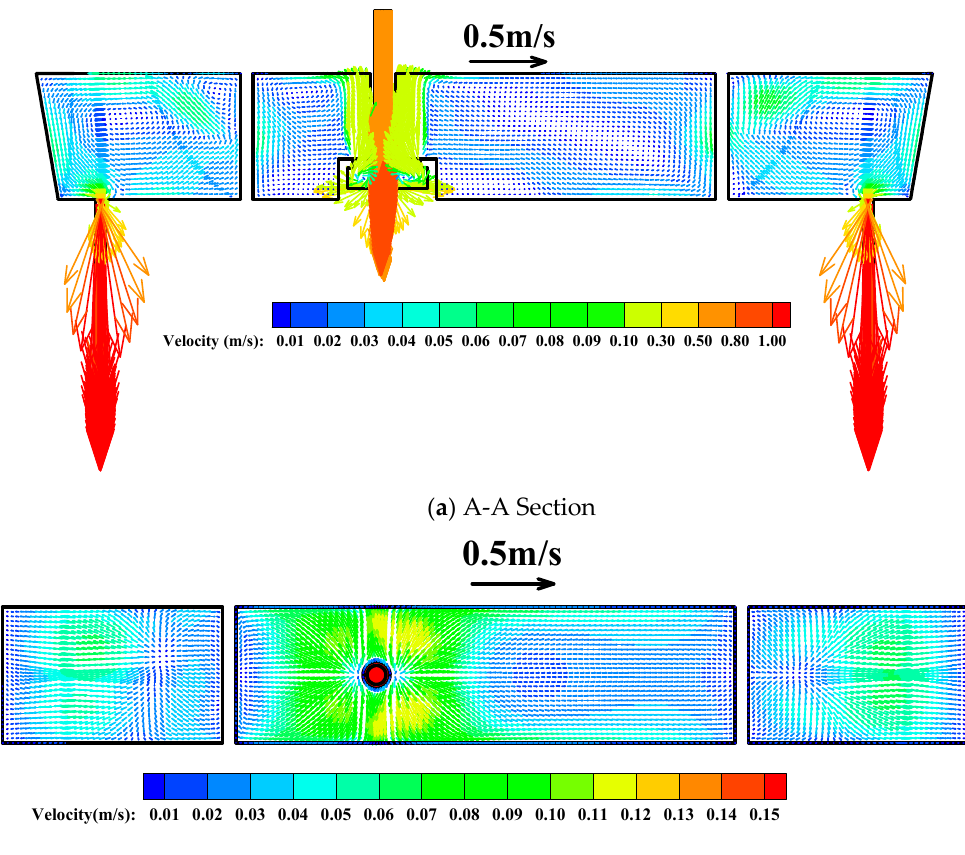
Figure 6. Fluid flow in the optimized tundish.